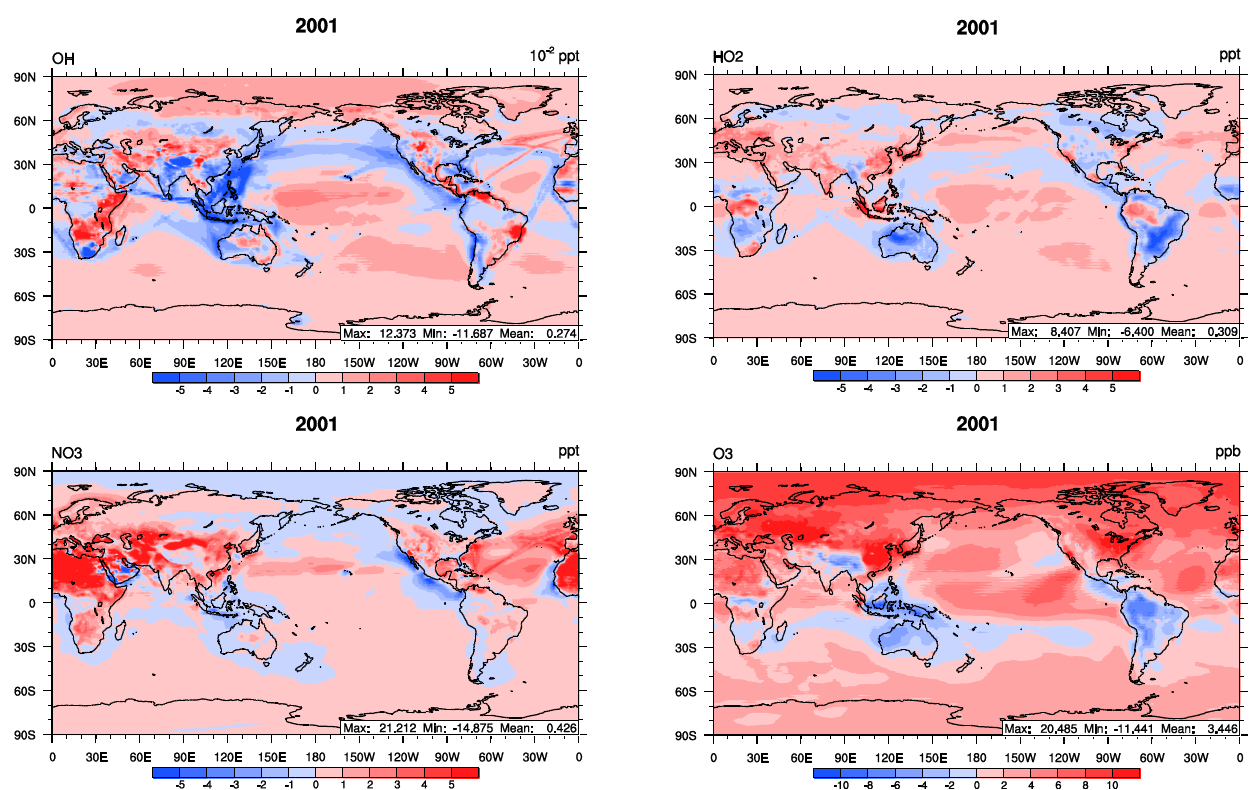
Figure 1b. Absolute differences between the mixing ratios of surface OH, HO 2 , NO 3 , and O 3 predicted from MAM_CB05_GE and climatology values used in MAM_SIM for 2001.